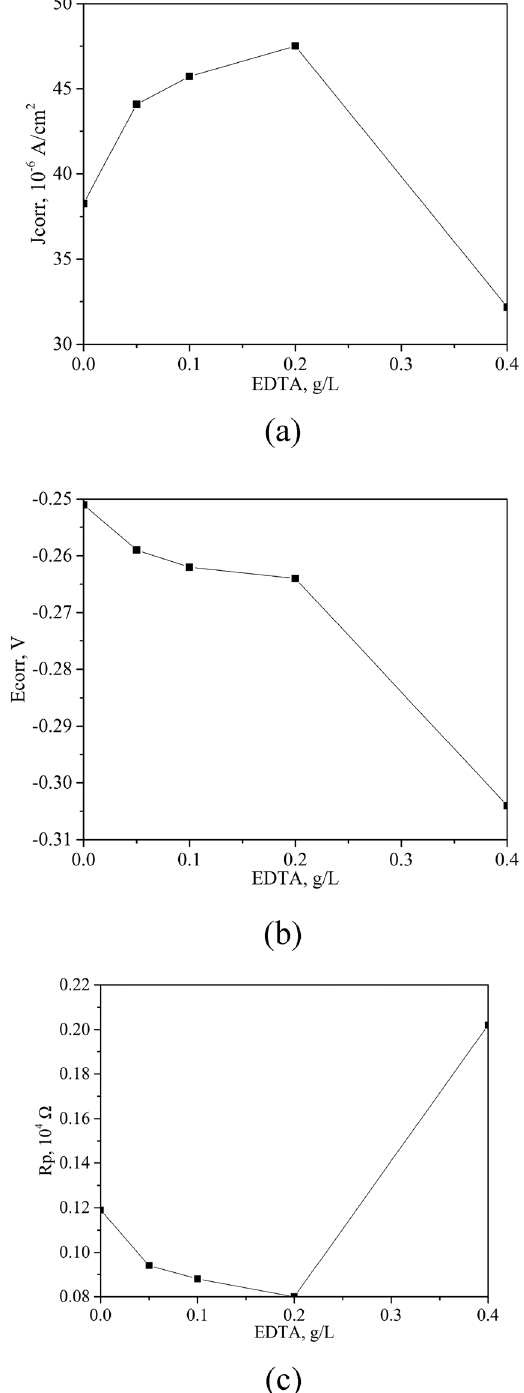
Figure 8: Electrochemical parameters of gold dissolution at di ff erent EDTA mass concentrations: ( a ) corrosion current density of gold dissolution; ( b ) corrosion potential of gold dissolution; and ( c ) polarization resistance of gold